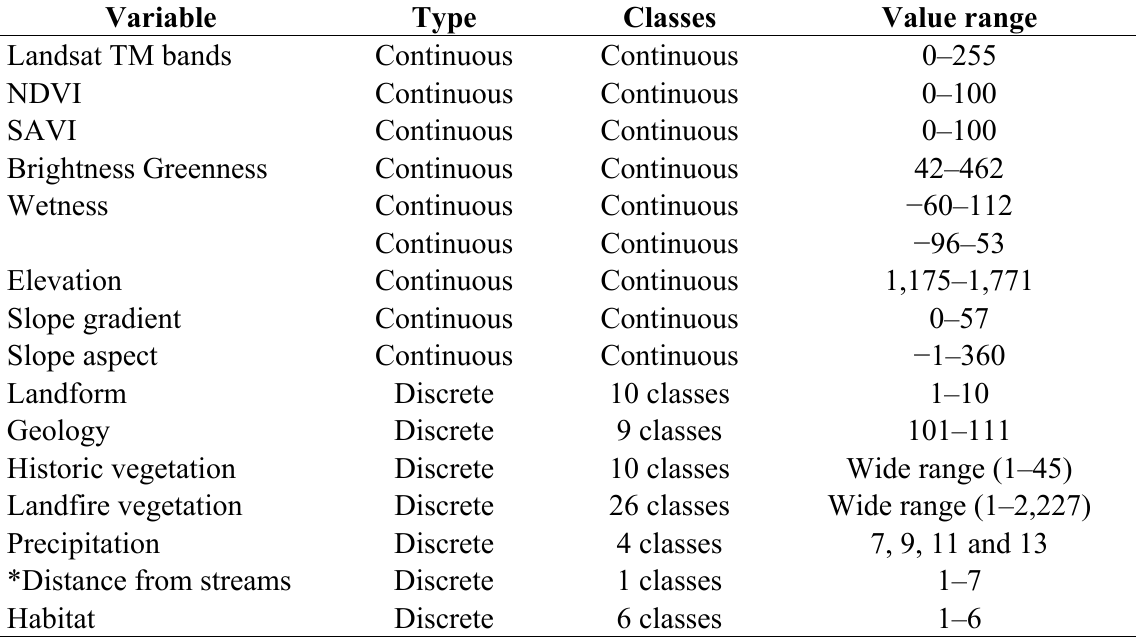
Table 2. Environmental variables and their